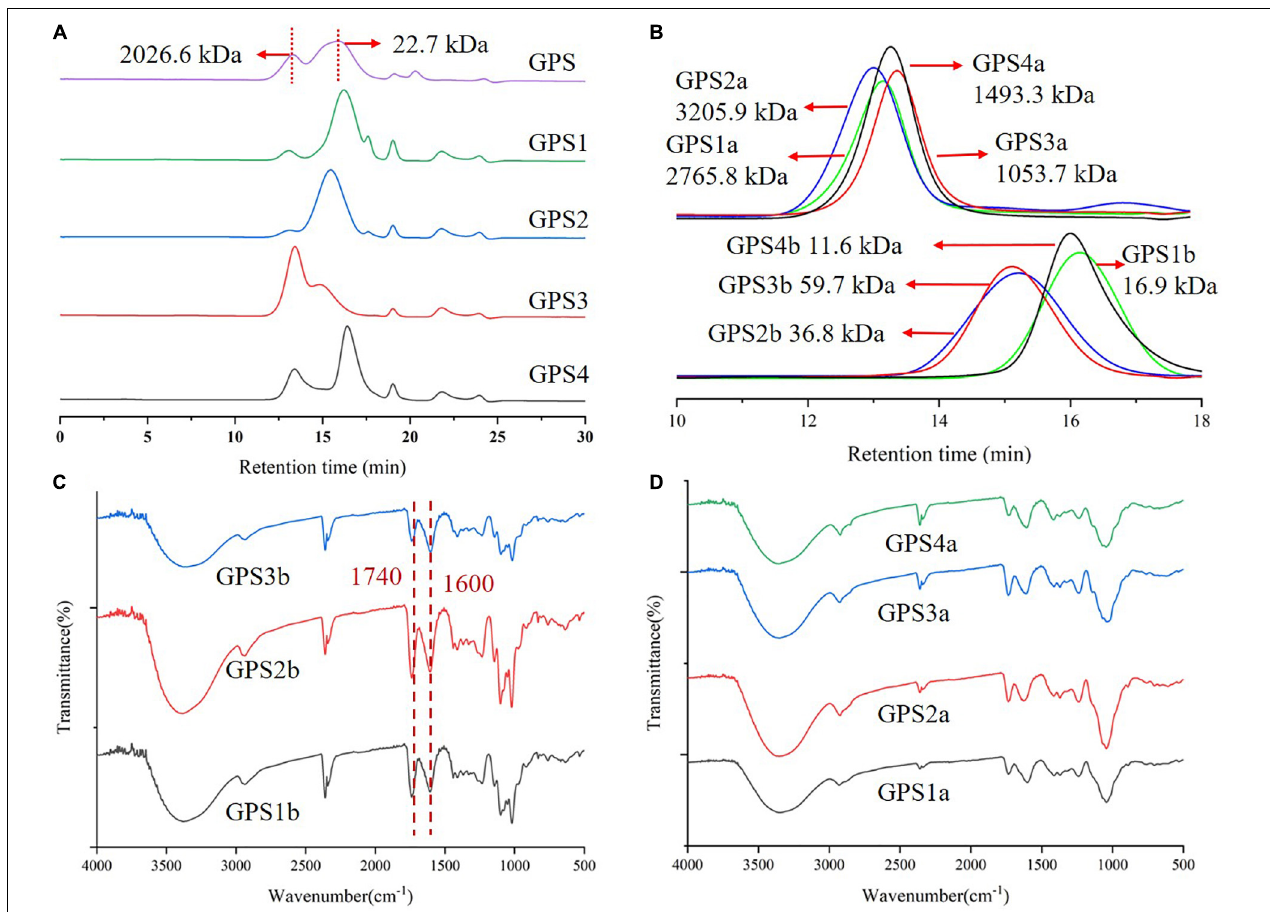
FIGURE 2 | (A) High-performance gel permeation chromatography (HPGPC) elution profile of Gougunao tea polysaccharide (GPS) and its DEAE Sepharose column purified fractions; (B) HPGPC elution profile of Sephacryl S-400 column purified fractions; (C) Infrared (IR) spectrum of GPS1b, GPS2b, and GPS3b. (D) IR spectrum of GPS1a, GPS2a, GPS3a, and GPS4b.